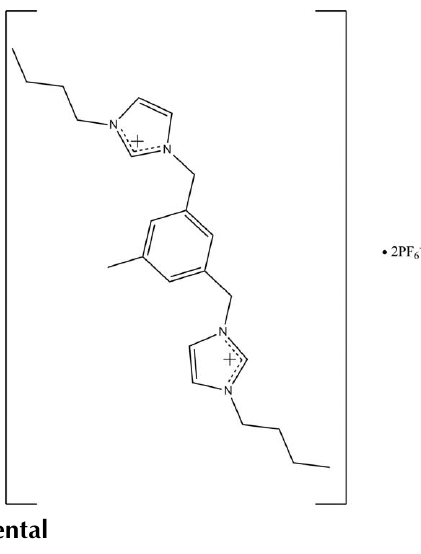
Experimental Crystal data